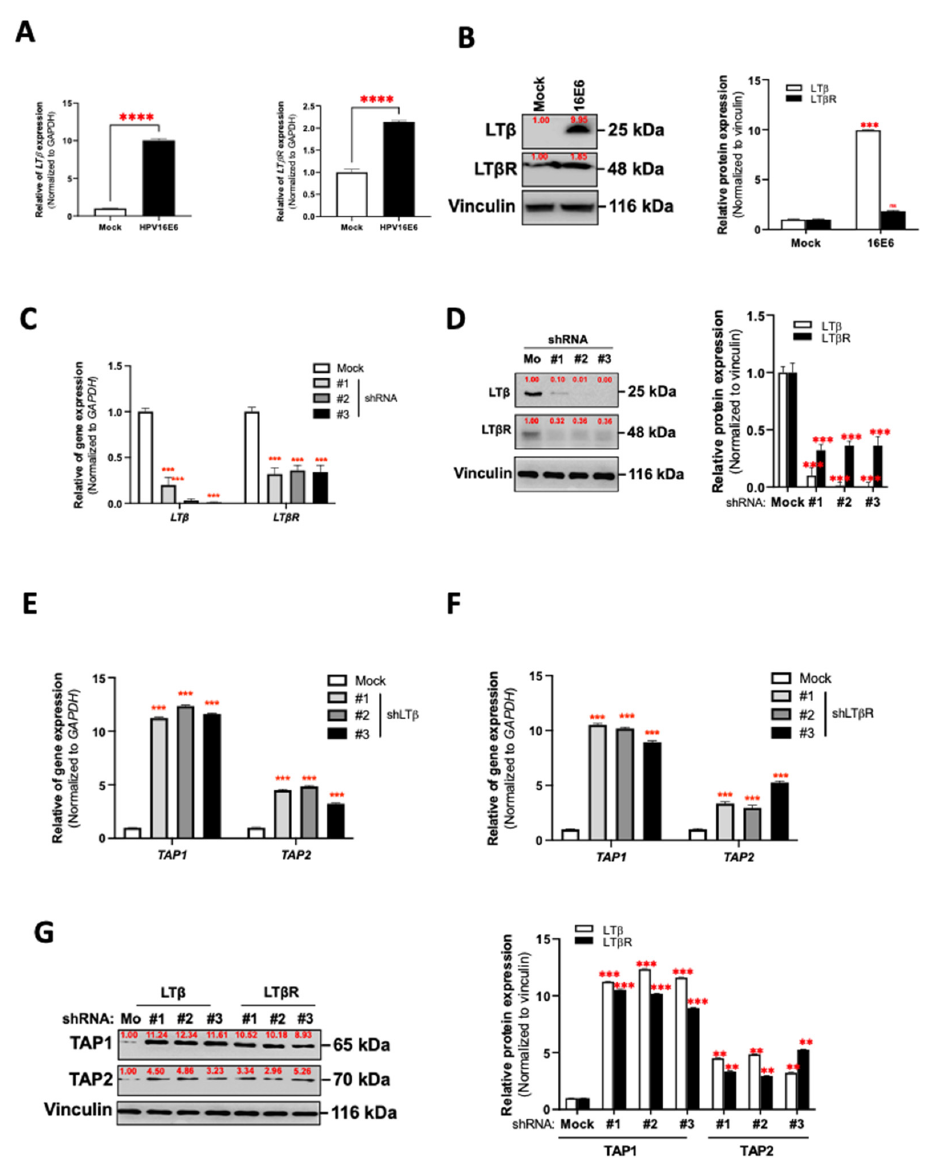
Figure 5. Role of LT β and LT β R in suppression of TAP1 and TAP2 in HPV16 E6-expressing oral epithelial cells. ( A , B ) The expression of LT β and LT β R mRNA and protein in HPV16 E6-expressing HTK1-K4DT was assessed by qRT-PCR ( A ) and immunoblotting ( B ). ( C , D ) The expression of LT β and LT β R mRNA and protein in HPV16 E6-expressing HTK1-K4DT transfected with shRNA-specific LT β , or LT β R, assessed by qRT-PCR ( C ) and immunoblotting ( D ). ( E – G ) The expression of TAP1 and TAP2 mRNA and protein in HPV16 E6-expressing HTK1-K4DT transfected with shRNA-specific LT β , or LT β R, assessed by qRT-PCR (( E ) for TAP1 and ( F ) for TAP2) and immunoblotting ( G ). All experiments were carried out in triplicate, and at least three independent experiments were performed. Red numbers indicate the relative intensity of the protein band according to ImageJ software. ** p ≤ 0.01; *** p ≤ 0.001; **** p ≤ 0.0001; #1, #2, and #3 indicated the number of LT β , or LT β R- specific shRNA. ns—not significant.